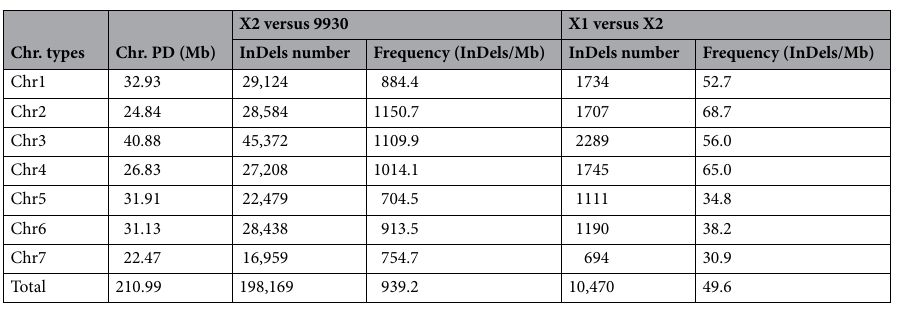
Table 2. Initially traced polymorphicInDel on X1 and X2 individual chromosomes with X2. Chr.: Chromosome; Chr. PD: chromosome physical distance; Mb: megabase-pairs.